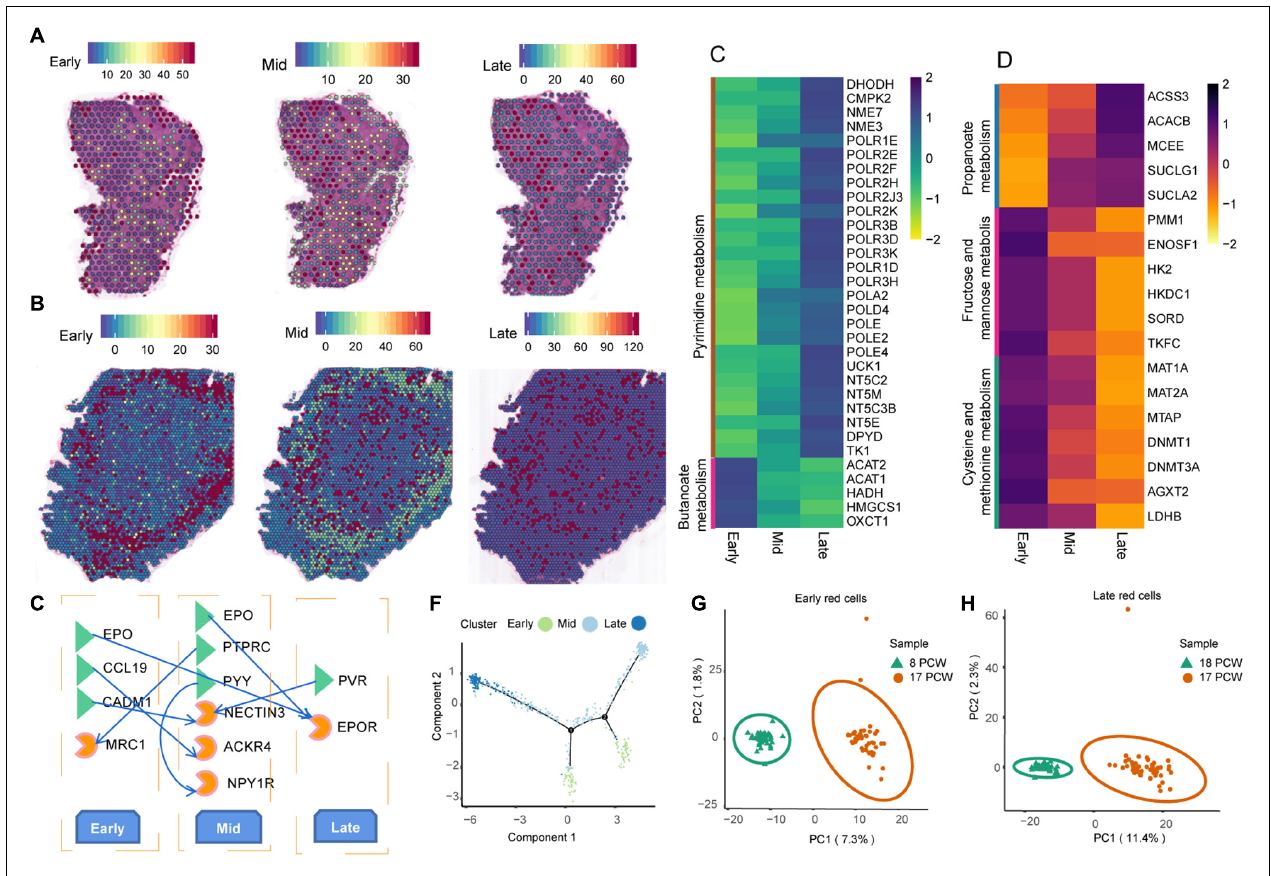
FIGURE 5 | Spatially resolved erythroid lineage differentiation and maturation pathway. (A,B) Visualization of the distribution of red blood cells across tissue sections from the 8 PCW (A) and 17 PCW liver (B) . (C,D) Heatmap of gradually down-regulated or up-regulated genes during erythrocyte differentiation and their corresponding enriched KEGG pathway in 8 PCW (C) and 17 PCW liver (D) . (E) Cellular communication between Early-Mid-Late erythroblasts in the 17 PCW liver. (F) Pseudotime analysis shows the differentiation and relation of early, mid, and late erythroblasts. (G,H) PCA plot showing different gene expression patterns between the two embryonic stages. The PCA plot analyses the 50 spots represented in early red cells and late red cells from 8 and 17 PCW liver. PCW, post-conception